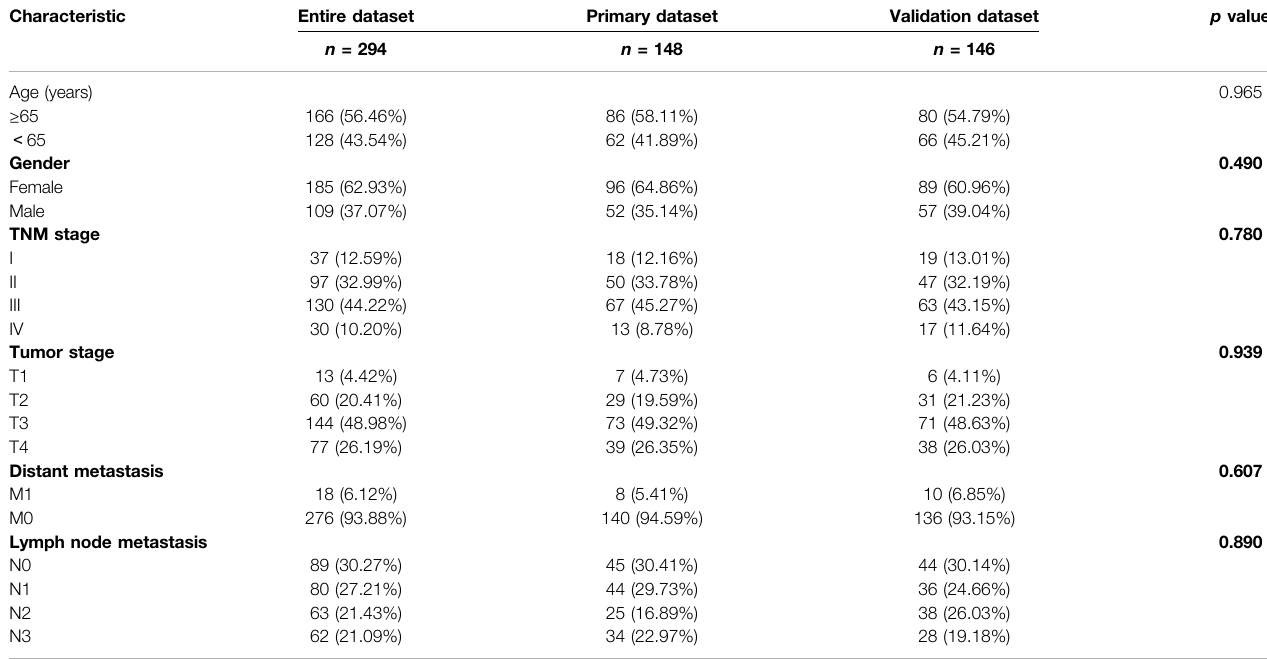
TABLE 1 | Baseline clinical characteristics of STAD patients involved in this study.